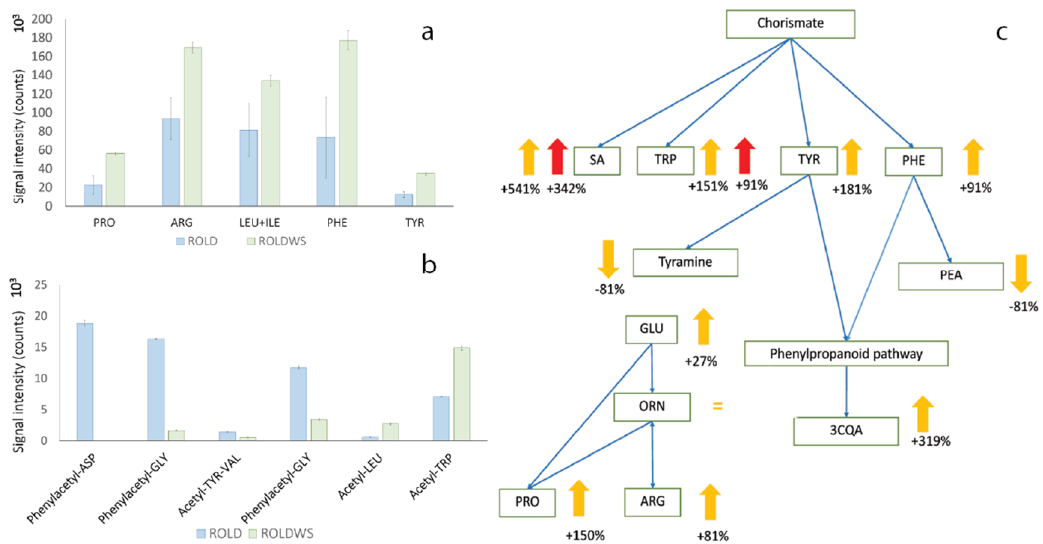
Figure 8. Levels of the main amino acids ( a ) and amino acid derivatives ( b ) in RolD and RolDWS plants; error bars indicate standard deviations and 10 X specifies the unit of visualization. Scheme of the biosynthesis ( c ) of the main amino acids and metabolites involved, as derived from the shikimate pathway, and their regulation during WS (yellow arrow) and HS (red arrow). The percentages of changes are shown under the arrows, in comparison to controls.